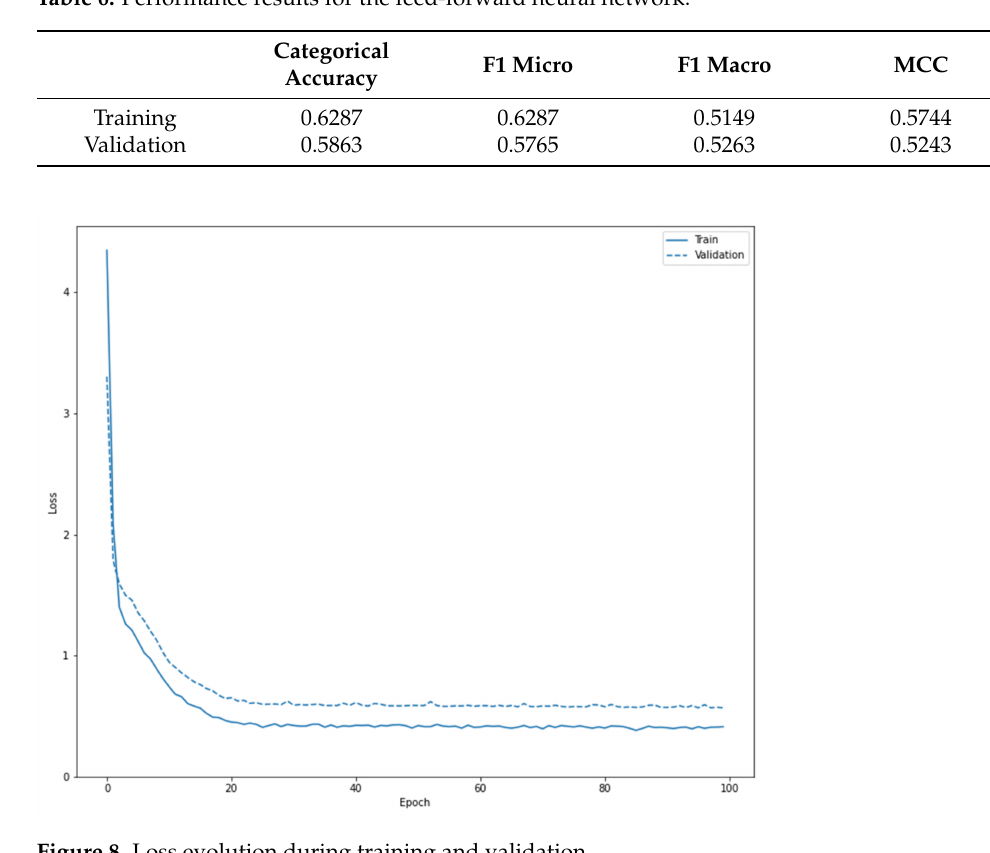
Figure 8. Loss evolution during training and